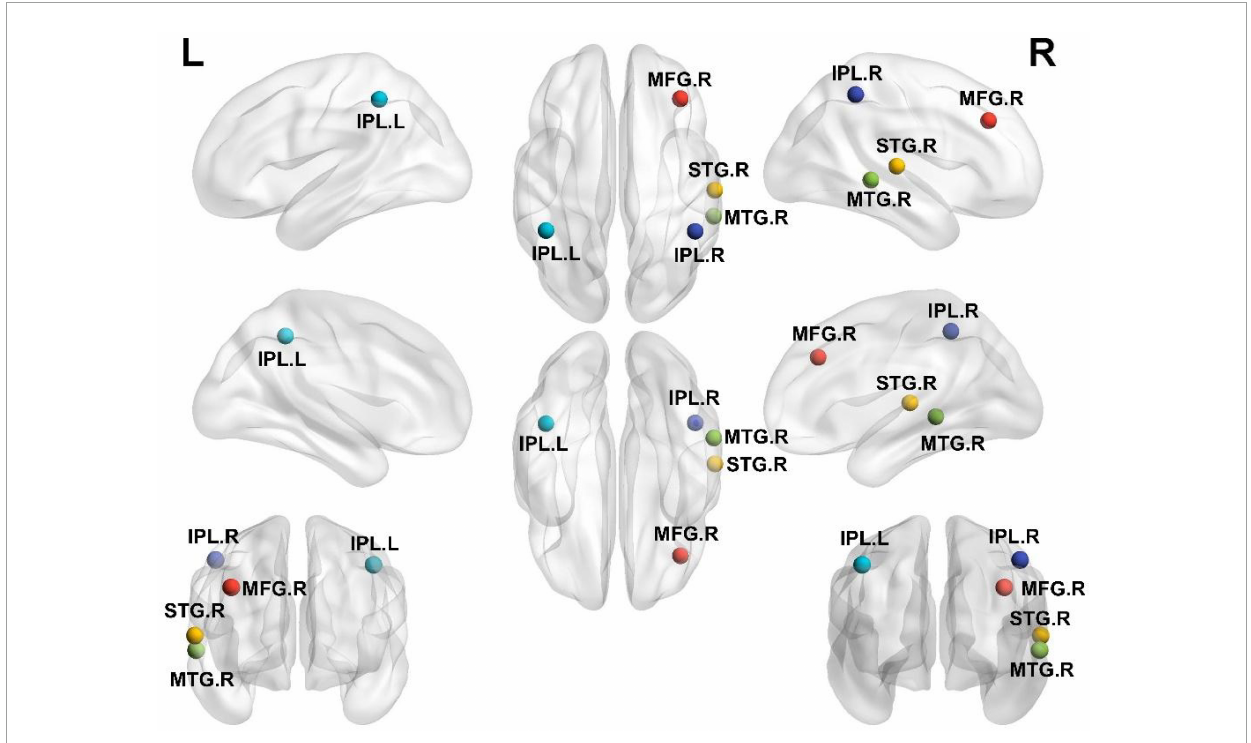
FIGURE2 Brain regions with significantly different DC values among the HC, SD, and MDD groups. L, left; R, right; IPL, inferior parietal lobule; MFG, middle frontal gyrus; MTG, middle temporal gyrus; STG, superior temporal gyrus.